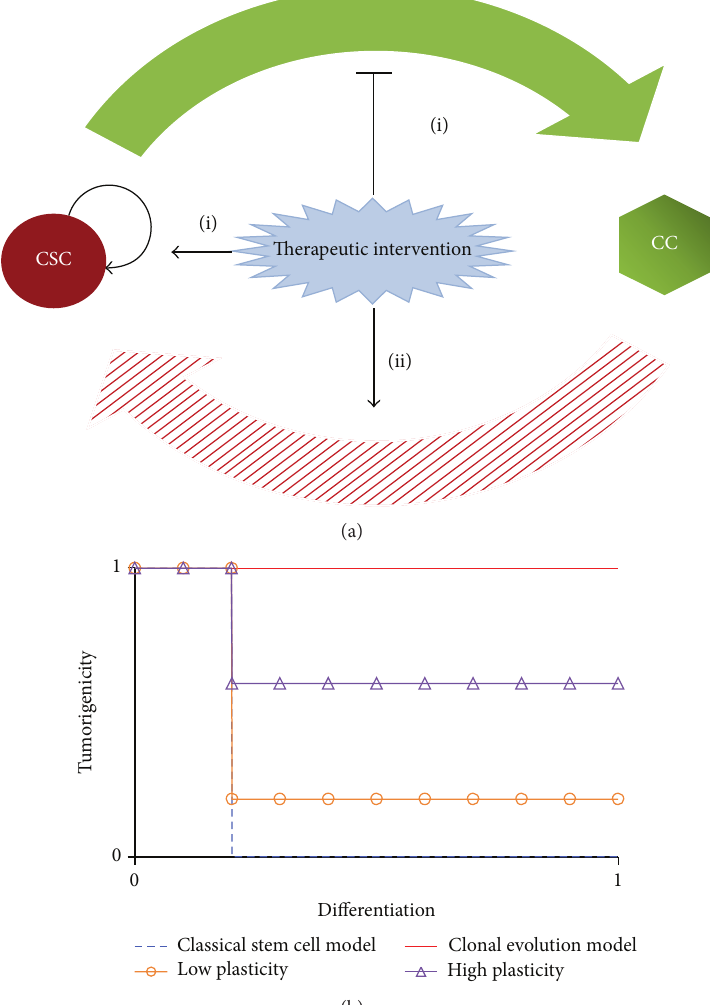
Figure 2: (a) Potential mechanisms by which (fractionated) IR increases the proportion of CSCs. Radiation induces the activation and stabilization of stemness-associated signaling (i) promotes symmetric self-renewal divisions, while repressing differentiation commitment, and/or (ii) evokes reprogramming of progenitor cells into a stem-like state. (b) The tumorigenicity is regulated by the degree of cell plasticity. 0 and 1 stand for minimum and maximum, respectively, in the according